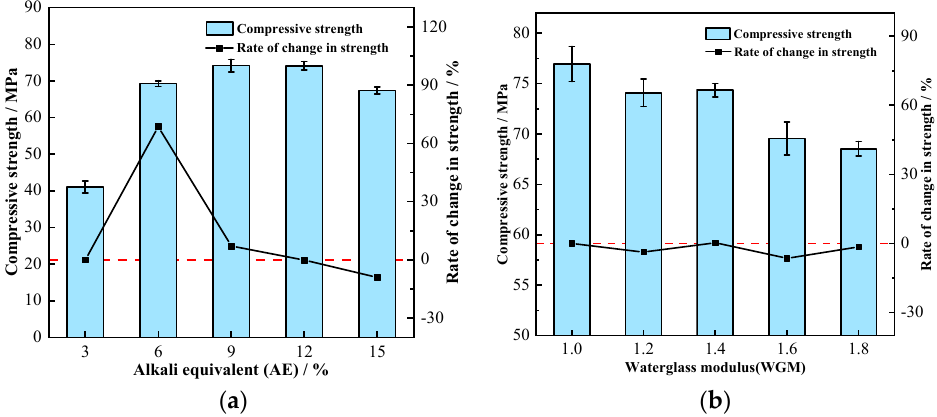
Figure 3. Relationship between initial compressive strength and activator parameters: ( a ) Relationship with AE; ( b ) Relationship with WGM.